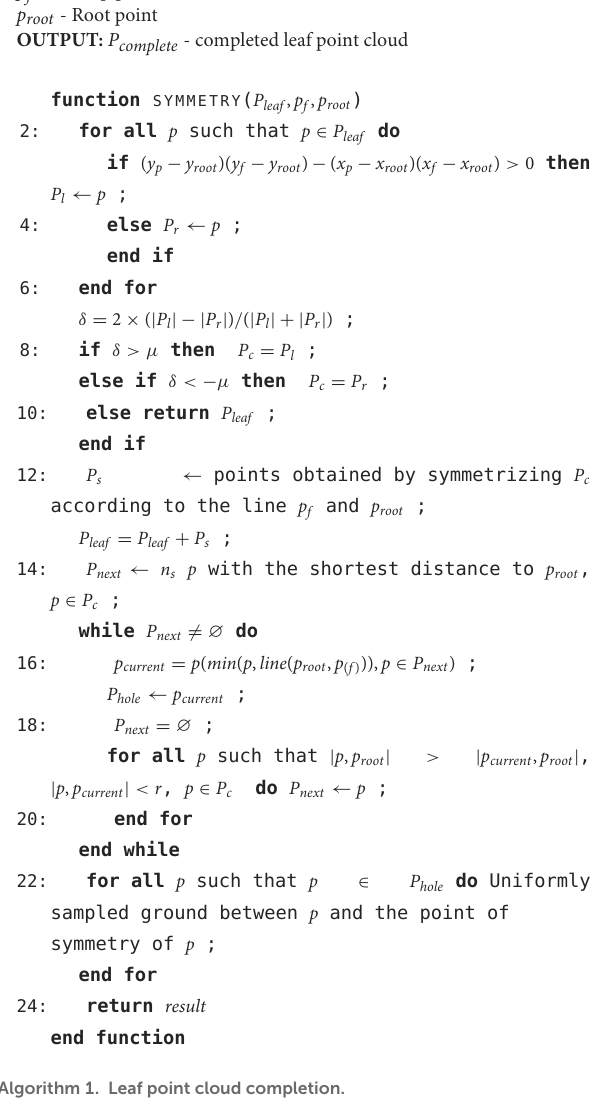
Algorithm 1. Leaf point cloud completion.